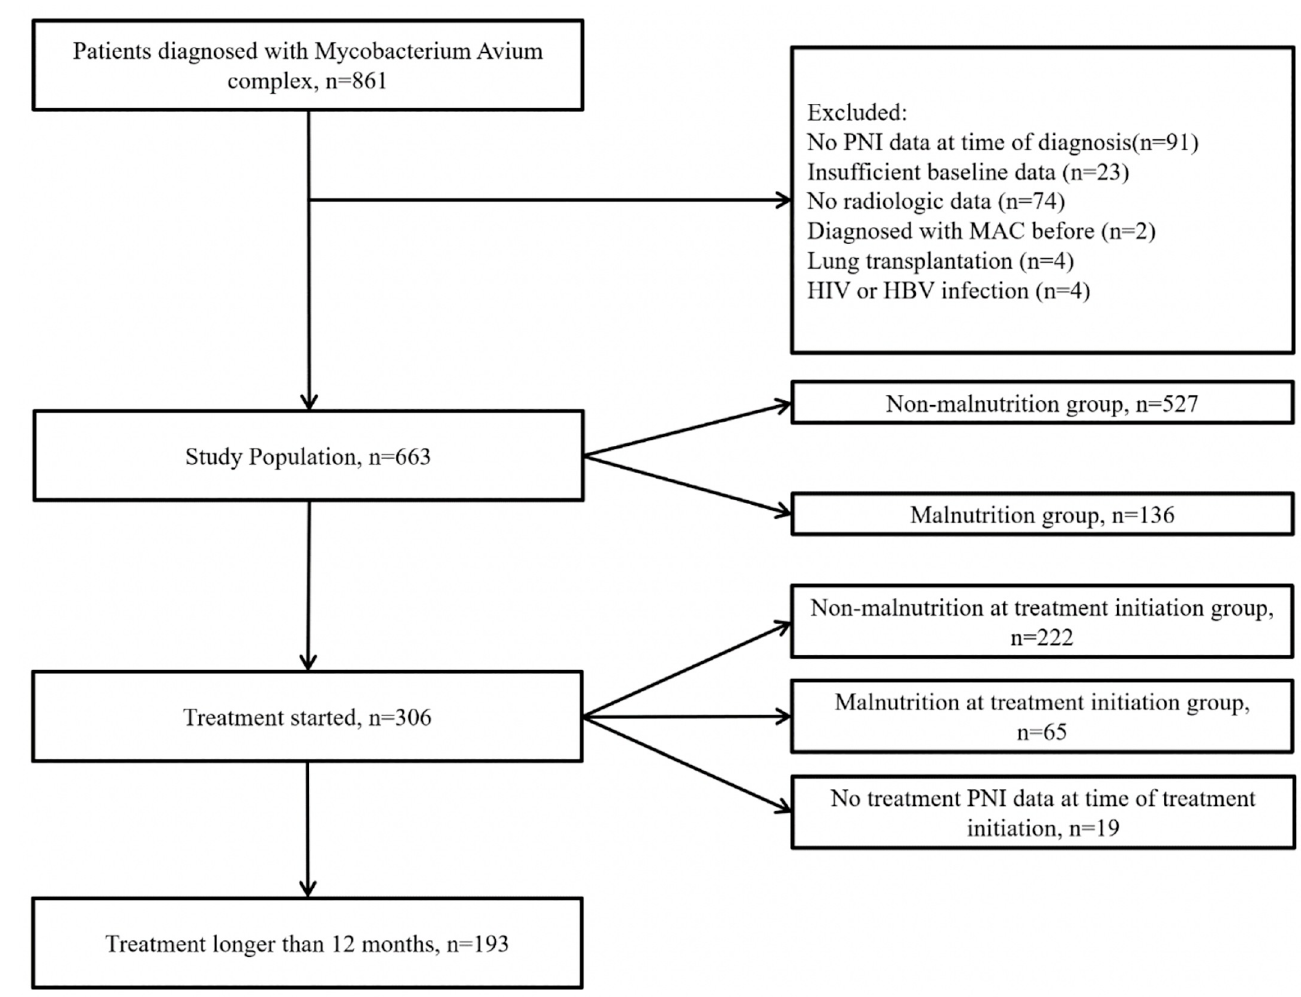
Fig 1. Flow diagram of subjects in this study. List of Abbreviations: HBV, Hepatitis B Virus; HIV, Human Immunodeficiency Virus; MAC, Mycobacterium avium complex; PNI, prognostic nutritional index.